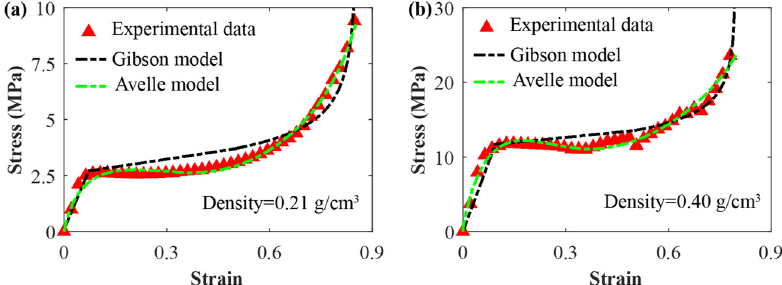
Figure 9: The experimental and theoretical stress – strain curves of the TFPU grouting materials with di ff erent densities: ( a ) 0.21 g · cm − 3 and ( b ) 0.40 g · cm − 3 . The theoretical ones were drawn according to equations ( 10 ) and ( 11 )